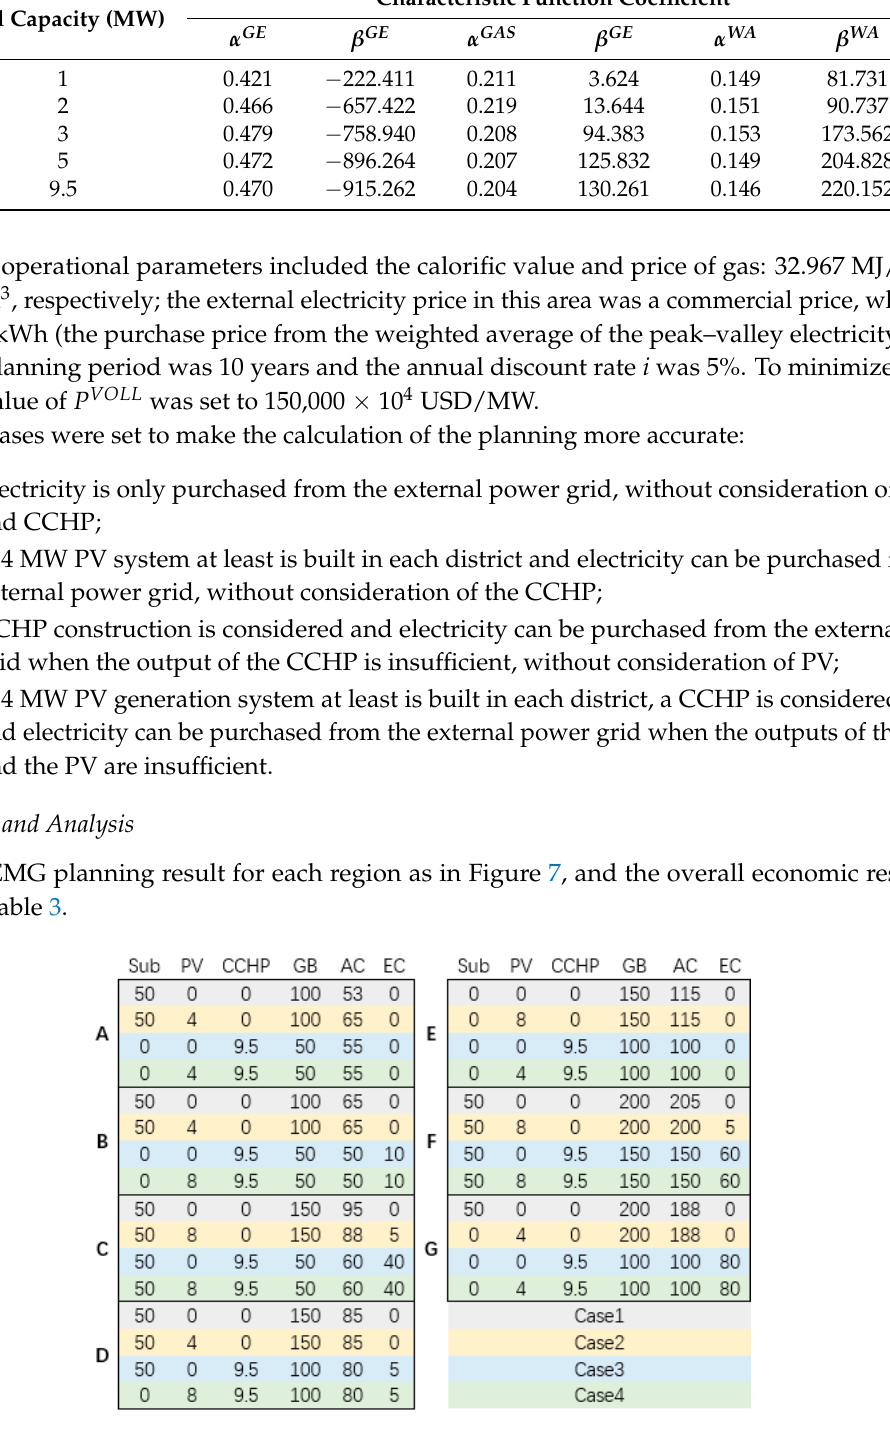
Figure 7. The IEMG planning result of each region in different cases (Unit: MW). Table 3. Cost comparison of the different case study scenarios.